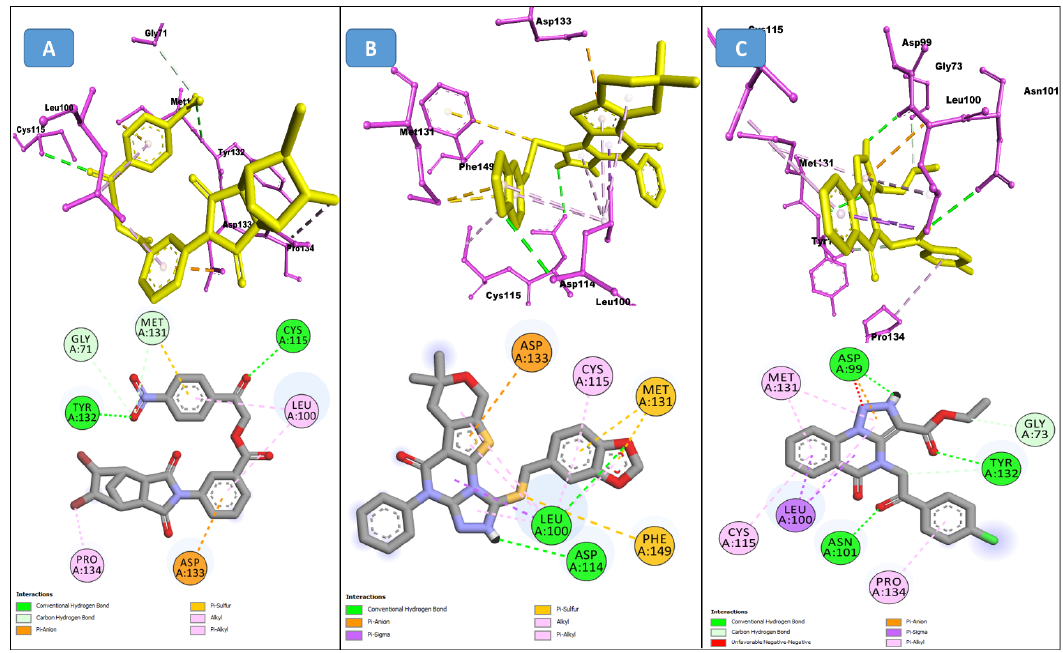
Figure 4. ( A ) Represents the 3- (Upper panel) and 2-dimensional (Lower pane) interactive poses of Specs_AK-918_11684151, while ( B , C ) are the representations of Specs_AJ-292_40706685 and Specs_AO-476_15578865 with the SARS-CoV-2 MTase allosteric site,